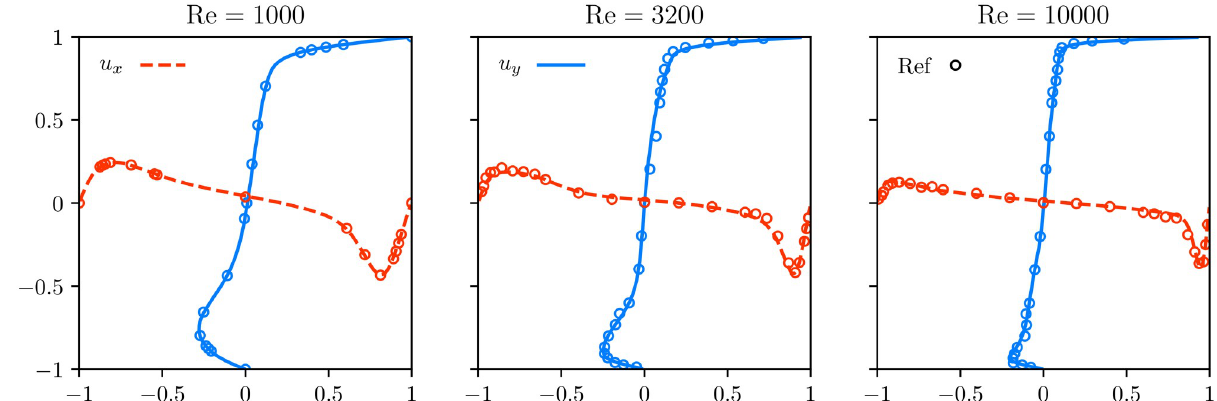
Fig 2. Profile of cubic cavity flow for two Reynolds numbers. Simulation results (solid lines) in a cubic lid-driven cavity along two center lines. Left image: Re = 1000, resolution N = 256, collision model BGK-W2, comparison of the results with reference values (circles) from spectral simulations provided in [67]. Middle image: non-stationary laminar flow at Re = 3200 simulated with a resolution N = 256 and collision model BGK-W2, averaged between a dimensionless time t = 50 and t = 250. Right image: turbulent flow at Re = 10000 simulated with a resolution N = 400 and RR collision model, averaged between a dimensionless time t = 150 and t = 500. The curves of the middle and right image are compared with experimental data extracted from figures in [66].